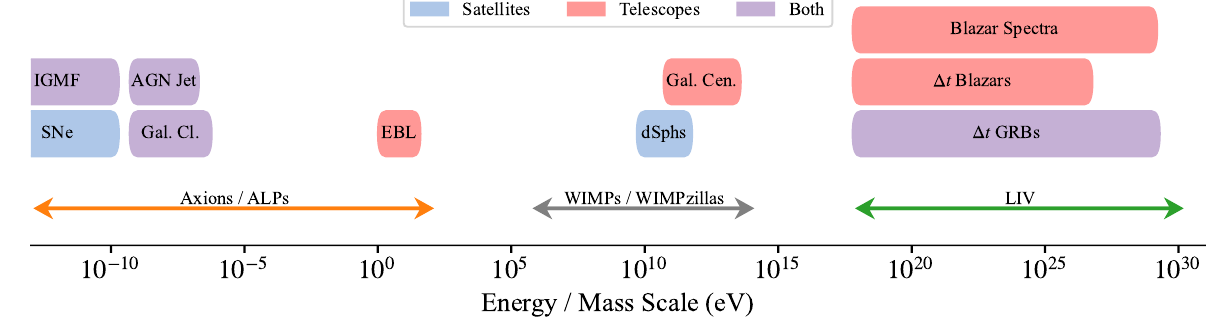
Figure 4. Energy and mass scales of physics beyond the standard model that can be probed with gamma-ray observations with satellites (blue boxes), ground-based telescopes (red boxes), or both (purple boxes). The range over which axions and ALPs are constrained lies below 10 eV. The mass range for self-annihilating WIMPs, between 10 6 and 10 14 eV, could be probed down to the thermal cross-section with future CTA observations of the Galactic center (Gal. Cen. [145]) or Fermi -LAT observations of dwarf spheroidal galaxies (dSphs [146]). LIV is probed up to 10 28 eV ( n = 1) with both temporal and spectral observations as labelled in the Figure. The reader is referred to the repository in [147] and Figure 1 in [66] for more specific constraints on the parameter spaces of ALPs and LIV,